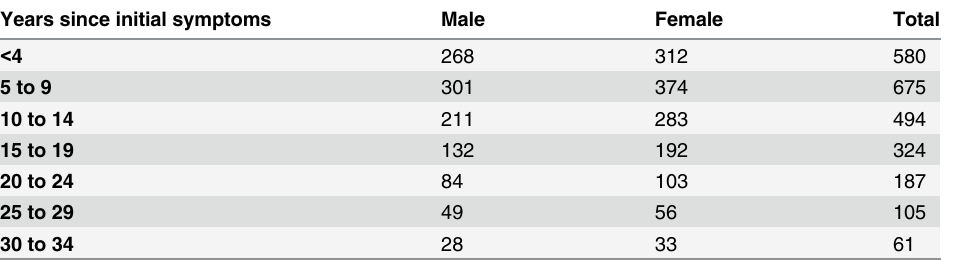
Years since initial